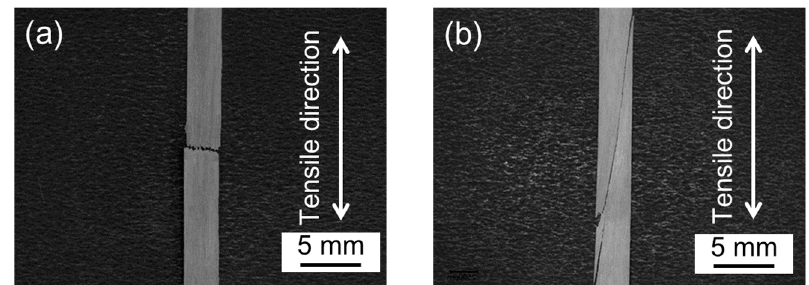
Figure 7. Classified failure modes were tensile fracture ( a ) and shear fracture ( b ).